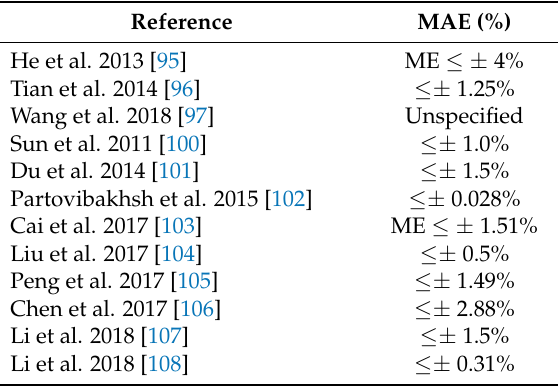
Table 8. MAE/ME of the UKF, variants of the UKF and hybrid UK-based SOC estimation method.